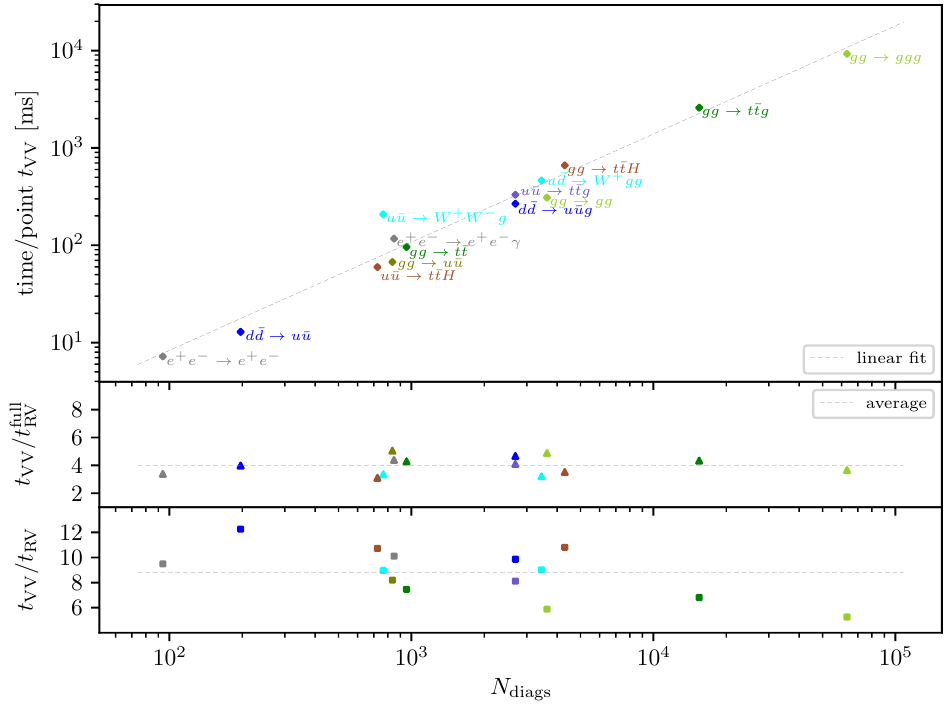
Figure 6 . Runtimes per phase-space point for the calculation of the two-loop tensor coefficients on a single core Intel(R) Core(TM) i7-6600U @ 2.6 GHz with 16GB RAM. The timings correspond to the QED and QCD processes in table 2 and are plotted versus the number N diags of irreducible two-loop diagrams. The upper frame displays the absolute two-loop timings t VV in ms. The middle frame shows the ratio t VV /t full , where t full is the time for computing the full one-loop probability RV RV density W (1) (including tensor integrals) for a related process with one extra gluon or photon 01 which enters the real-virtual part of the same NNLO calculation. The lower frame shows the ratio t VV /t RV , where t RV is the cost of computing the one-loop tensor coefficients of W (1) without tensor 01 integrals. Colour and helicity sums are included throughout, and the latter are always carried out on-the-fly. All timings have been taken in DP using the GNU Fortran 7.5.0 compiler and averaging over 1000